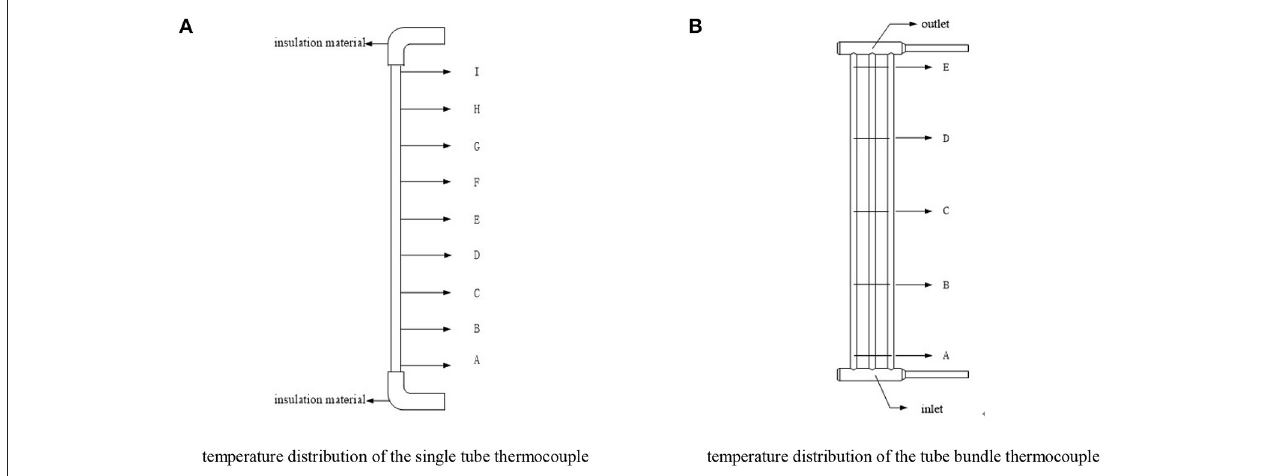
FIGURE 2 | Distribution of the thermocouple (A) temperature distribution of the single tube thermocouple. (B) temperature distribution of the tube bundle